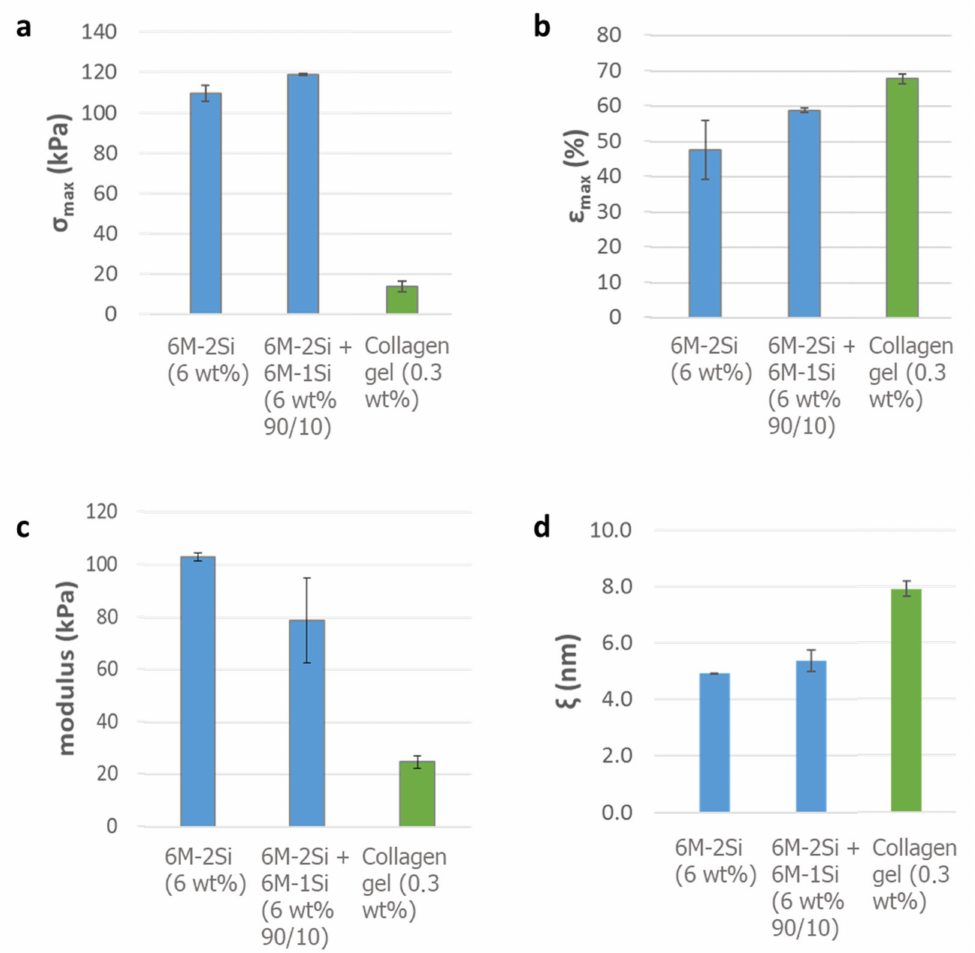
Figure 5. Rheological evaluation of the collagen type I hydrogel and hybrid hydrogels obtained with 0.1 mg/mL NaF and 10 mg/mL glycine at 37 ◦ C in DPBS pH 7.4 and aged for six days. ( a ) Maximal stress before rupture; ( b ) maximal strain before rupture; ( c ) Young’s modulus; ( d ) mesh size calculated by